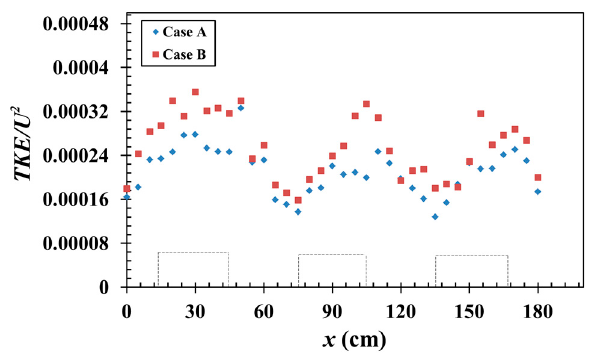
Figure 11. Deviations of depth-averaged turbulent kinetic energy along length for both Case A and Case B. The dashed boxes denote the vegetation patches.